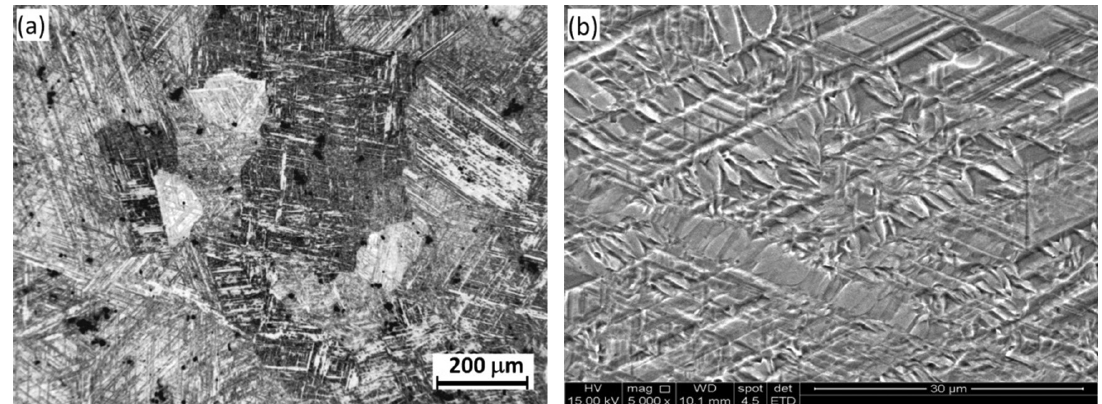
Figure 6. (a) Optical and (b) scanning electron micrographs of hot-rolled sample. Sample was etched with 4%